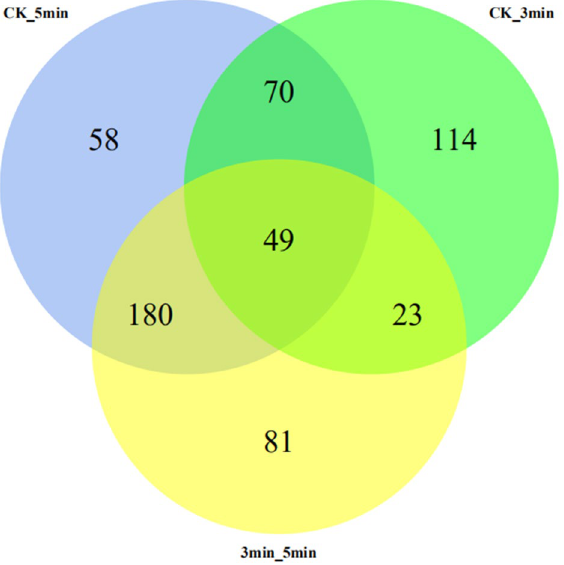
Figure 2. Venn diagram of the differential metabolites among three comparative groups.